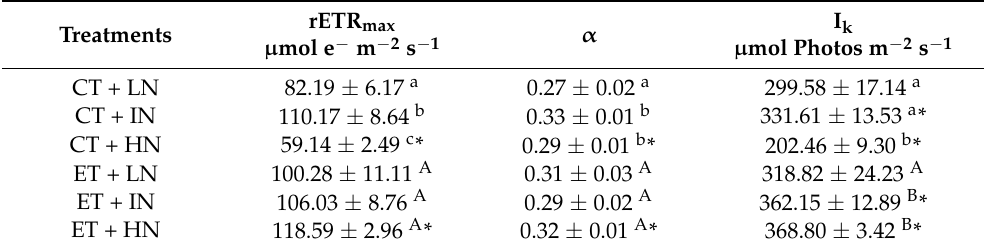
Figure 3. Rapid light curve (RLC) of photosynthetic system II (PSII) of S. horneri under LN, IN, and HN, treated by CT and ET. Data are means ± SD (n = 3). Table 3. Photosynthetic parameters of the rapid light curve of S. horneri under LN, IN, and HN treated by CT and ET. rETR max represents the maximum relative electron rate, α represents the light harvest- ing efficiency, and I k represents the photosynthesis saturated light intensity. Significant differences are indicated by different letters (one-way ANOVA), and values represent the mean ± SD (n = 3). * represents a significant difference ( p < 0.05) among temperature levels at the same N concentration, the different capital letters represent significant differences ( p < 0.05) among N concentrations at the elevated temperature, while the different lower-case letters represent significant differences ( p < 0.05) among N concentrations at the ambient